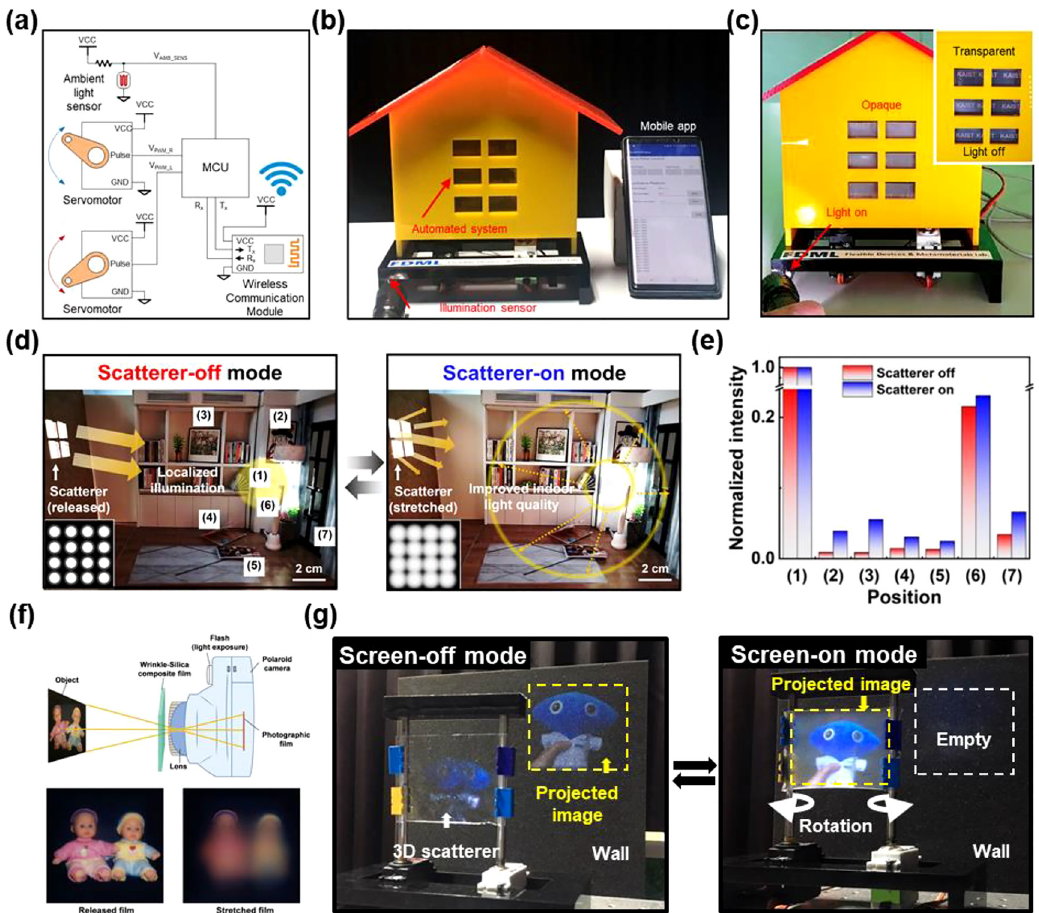
Figure 13: Emerging applications of scatterers using smart optical modulations. (a) A circuit diagram and (b) an overview of a self-regulating smart window device enabled by a mobile app. (c) Automatic response mode of a smart window device designed to operate in response to the surrounding illumination conditions. (d) Demonstration of a smart window that cancontroltheilluminationconditionsofamodelroombyswitchingthescatterermodeonandoff.(e)Lightintensitiesatdifferentpositionsin theroomnormalizedbythatatposition(1).(f)PatternencryptionfeatureofasmartwindowapplicationbycouplingthescattererwithPolaroid camera. (g) Next-generation rollable application of a scatterer as an arbitrary projector screen, integrated with the Internet of Things Technology. Reprinted with permission from Refs. [17, 84,